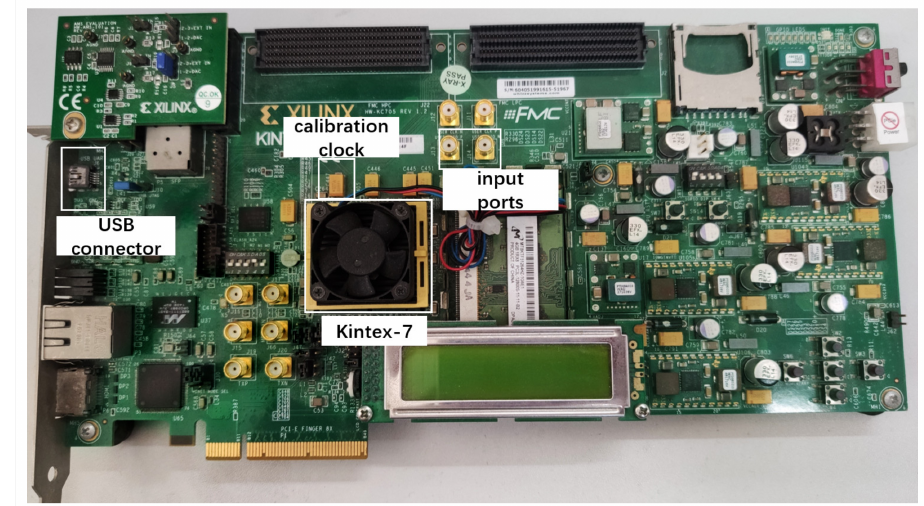
Figure 7. A picture of the evaluation board.